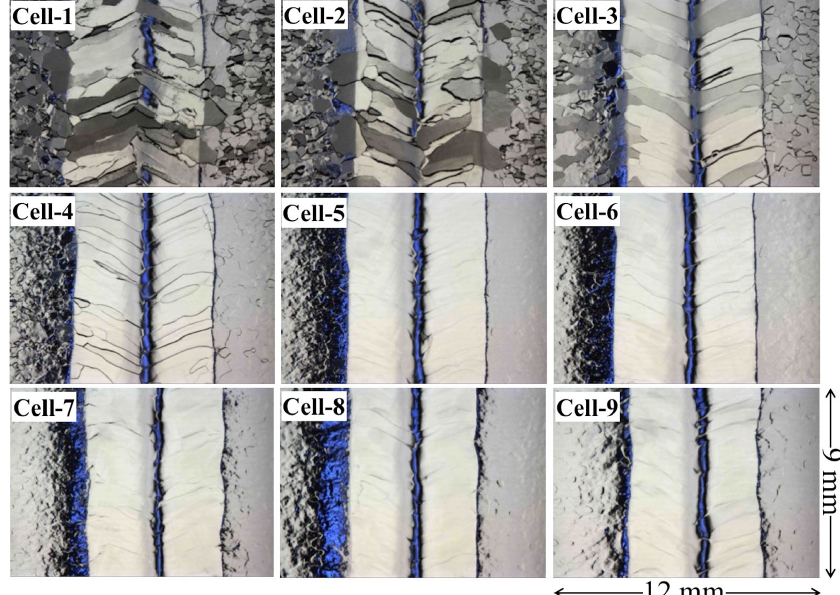
FIG. 10. Optical images of the equator surfaces after the VEP performed with initial parameters which were similar to those optimized for the single-cell cavity. Cell 1 represents the top cell in the VEP process. All the images have the same size of 12 × 9 mm.